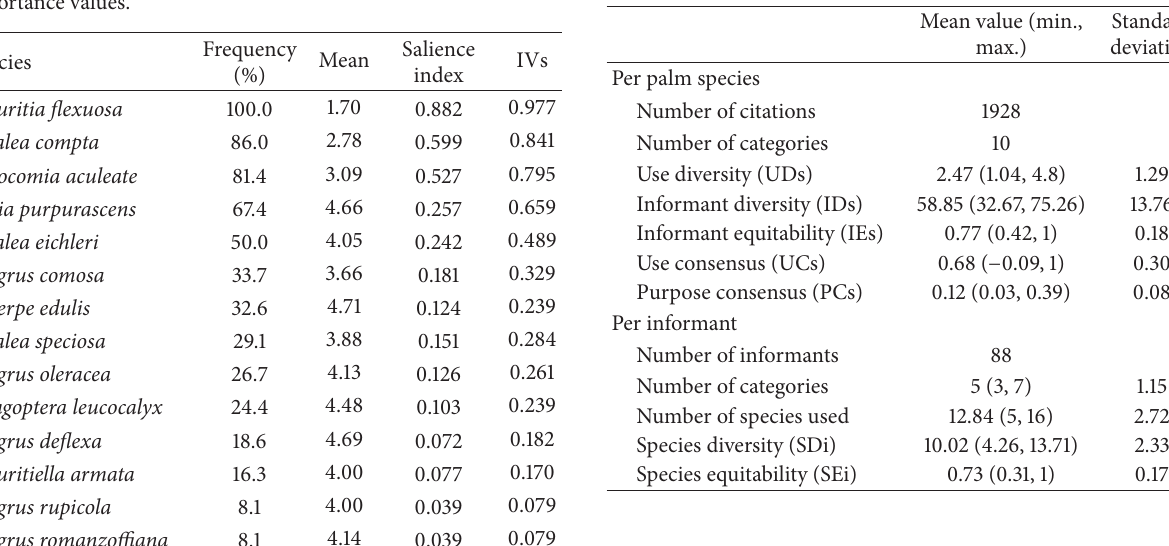
Table 7: Summary of the quantitative values capturing the uses and importance of palm species among the Kalunga of the Engenho II community, Cavalcante, GO, central western